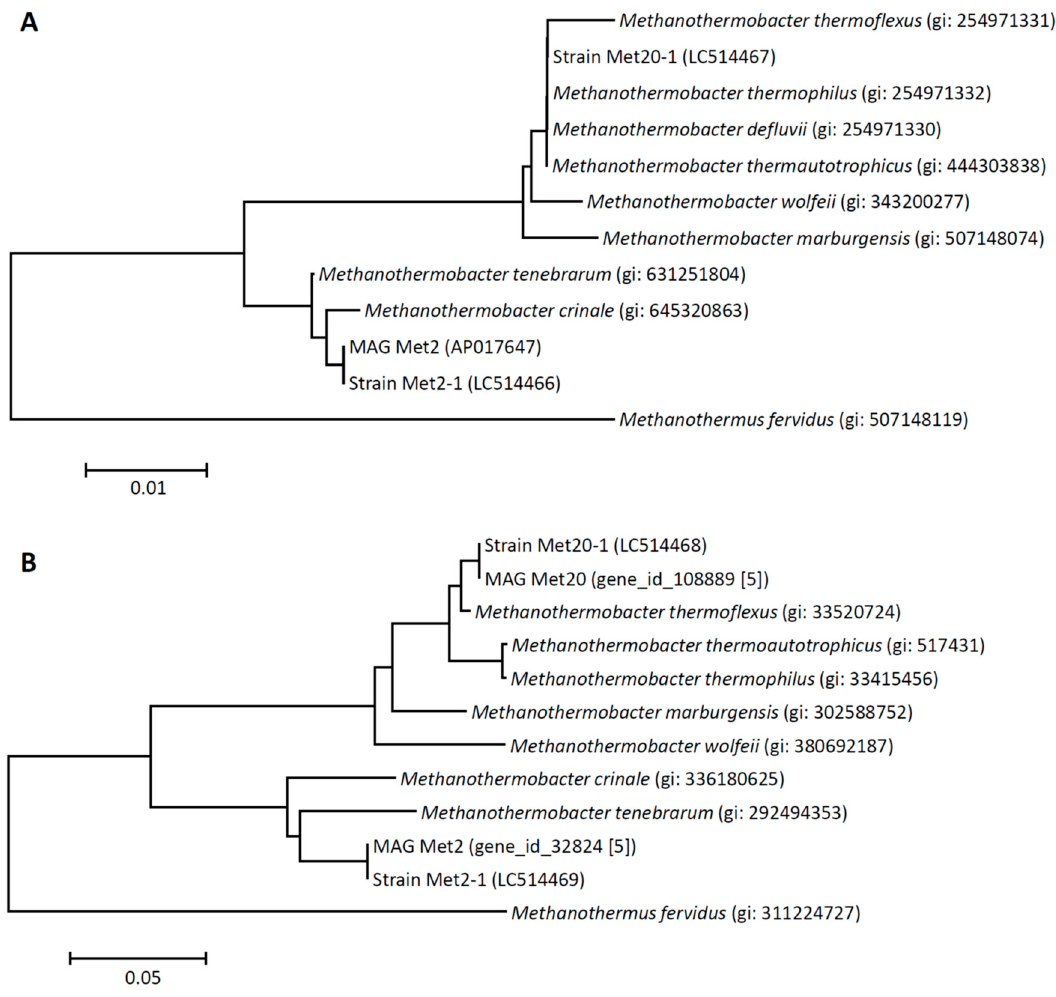
Figure 2. Phylogenetic trees based on 16S rRNA gene sequences ( A ) and mcrA sequences ( B ) showing phylogenetic relationships among archaea affiliated with the genus Methanothermobacter . Methanothermus fervidus DSM 2088 is used as the outgroup. Bootstrap values (100 trials, only values greater than 50 are shown) are indicated at branching points. Sequence divergences are indicated with bars, and accession numbers are shown in parentheses.